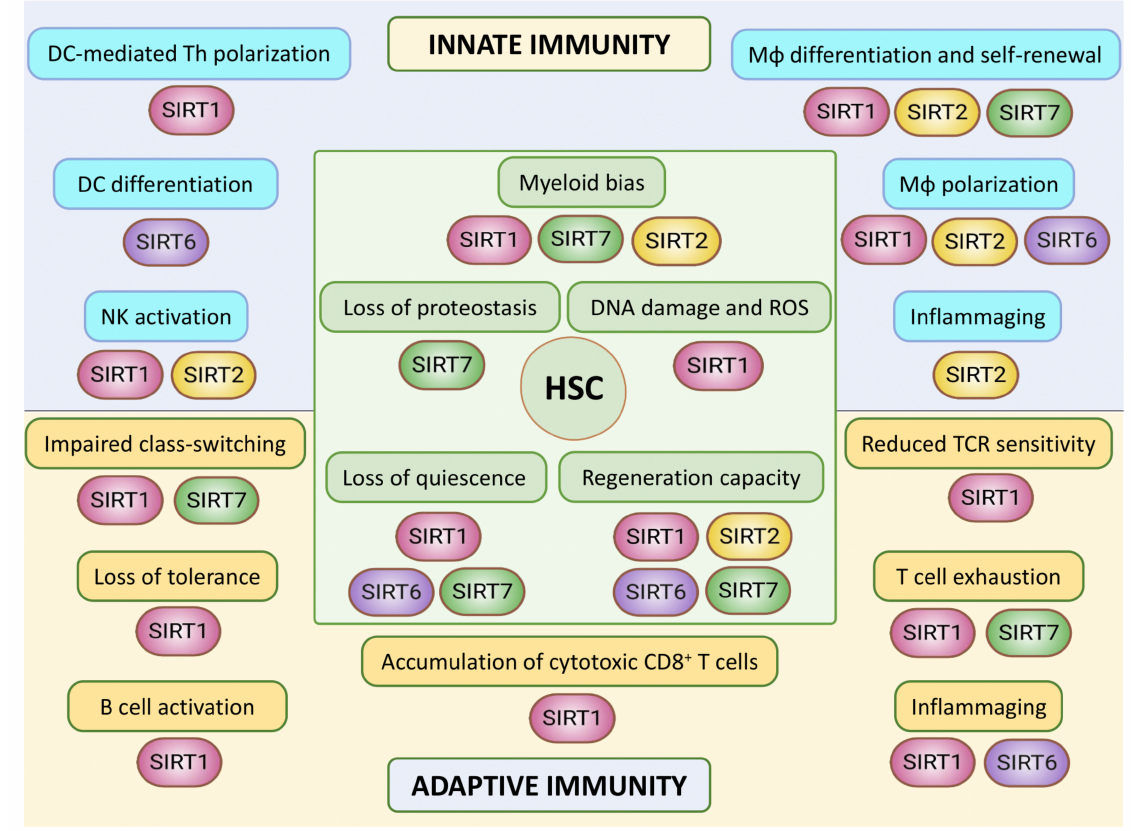
Figure 7. Hallmarks of immune aging and their connections to nuclear sirtuins. In the central part, different features associated with the aging of hematopoietic stem cells (HSCs) and their relationship with sirtuin activity are depicted. Nuclear Sirtuins are important to prevent several aspects of HSC aging, including DNA damage, myeloid bias and loss of proteostasis and quiescence, as well as maintenance of HSC regeneration capacity [31,35–37,39]. In the upper part, aging-associated features of innate immune cell types are summarized. SIRT1 and SIRT6 are important for DC-mediated Th polarization and DC differentiation, respectively [48,80–82]. SIRT1, SIRT2, SIRT6 and SIRT7 also play relevant roles in macrophage (M ϕ ) biology, and SIRT2 has been linked to inflammaging [47,57,58,65]. In NK cells, SIRT1 and SIRT2 regulate their cytotoxic functions in the contexts of aging and anticancer response, respectively [79,84]. In the lower part, characteristics of the aging of the adaptive immune cell compartment are shown. SIRT1, SIRT6 and SIRT7 are important for several aspects of T cell biology and aging [40,95,100,109,111,112]. SIRT1 is further involved in B cell activation and immunoglobulin gene class-switching, where SIRT7 also plays a role